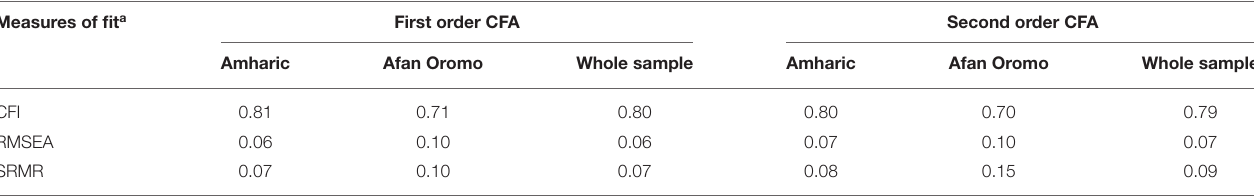
TABLE 2 | Confirmatory factor analyses